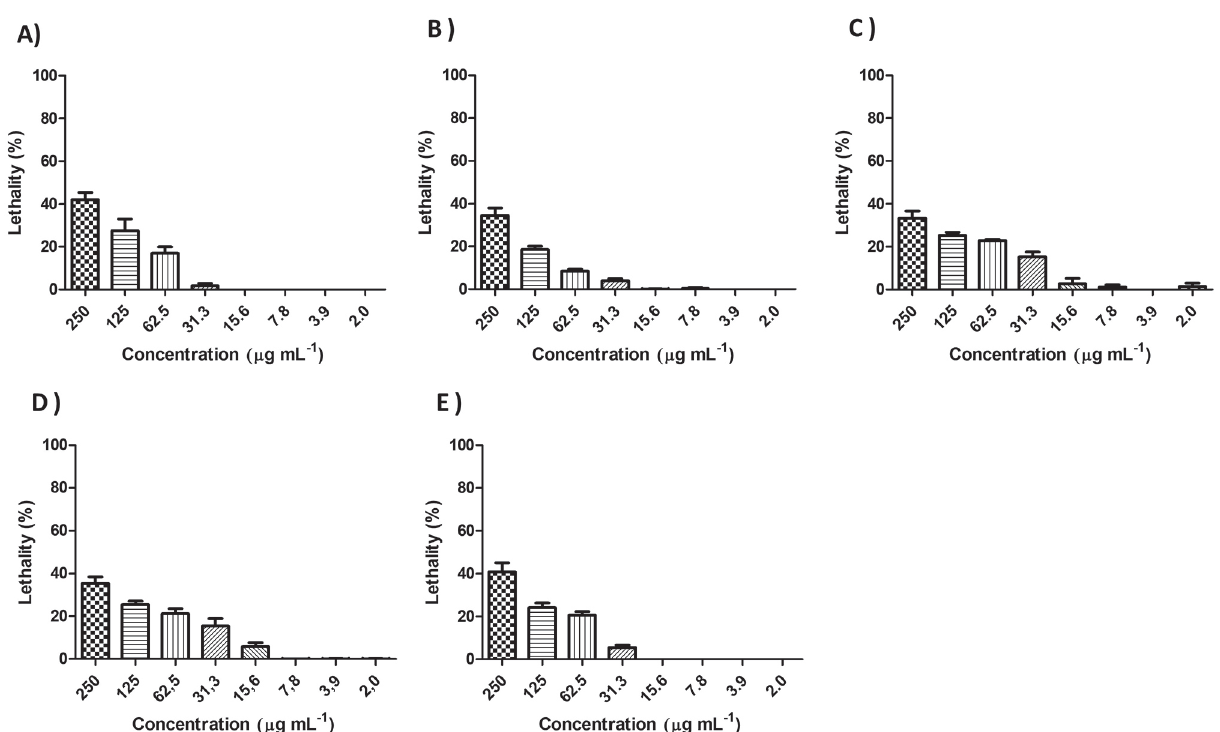
FIGURE 6 - Cytotoxicity evaluation on MRC-5 cells by the resazurin method in different concentrations of insulin (A), blank chitosan:dextran sulfate (1:9) nanoparticle (B), insulin-loaded chitosan:dextran sulfate (1:9) nanoparticle (C), blank chitosan:dextran sulfate (6:4) nanoparticle (D), insulin-loaded chitosan:dextran sulfate (6:4) nanoparticle